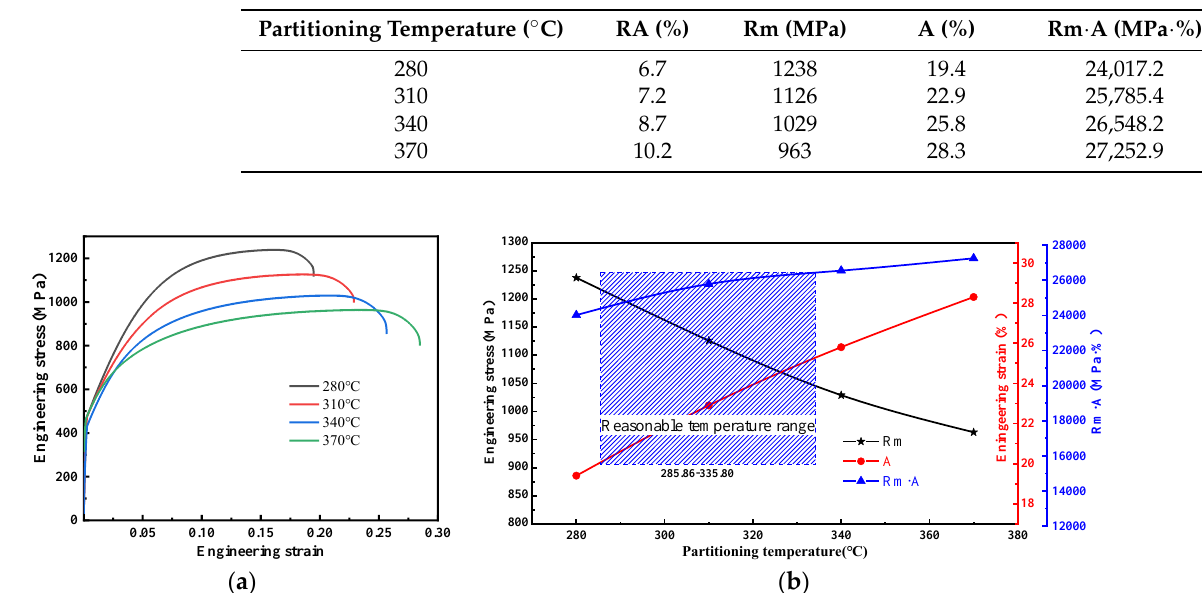
Figure 8. ( a ) Engineering stress – strain curves of experimental steels and ( b ) The relationship between mechanical properties and partitioning temperature of test steel. Table 1. Mechanical properties of steel treated at different partitioning temperatures.